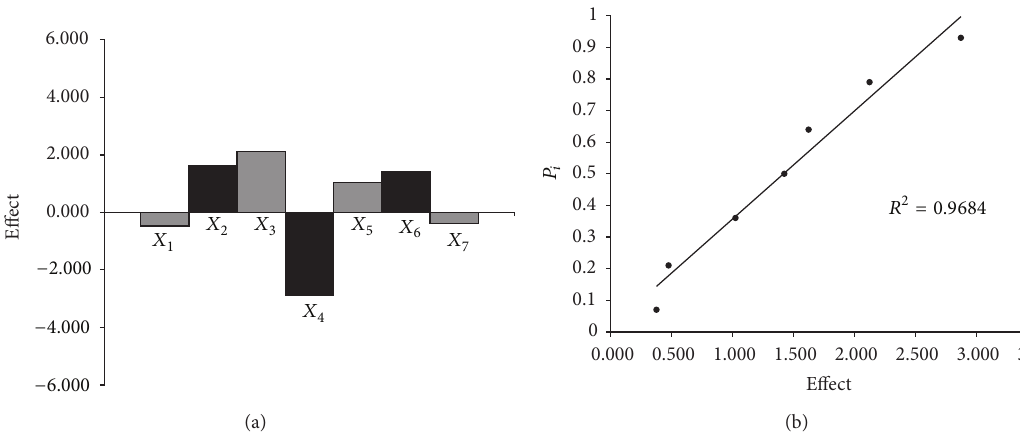
Figure 4: Robustness test: the effect of the factors (a) and a half-normal probability plot of effects (b) for determination of hydrocortisone acetate in examined drug.